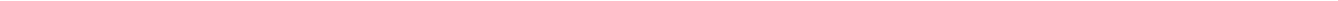
Figure 3 | Knockout of VCAM1 in oligodendrocytes decreases myelin marker protein expression in mice. ( a , b ) MBP-Cre-driven VCAM1 conditional knockout ( VCAM1 fl/fl ; Mbp-Cre ) and control mouse spinal cord cross sections at postnatal day 7 were stained with an antibody against GFAP (green) or NeuN (red). Data are representative. Scale bar, 200 m m ( a ); 100 m m ( b ). ( c ) The intensity of GFAP staining per one square millimetre was semi-quantified at postnatal days 7, 14 and 21. Data were evaluated using Student’s t -test (non-significance; n ¼ 6 slices of two independent experiments). ( d ) The number of NeuN þ cells per field was counted. Data were evaluated using Student’s t -test (non-significance; n ¼ 5 slices of two independent experiments). ( e ) Spinal cord cross sections of VCAM1 fl/fl ; Mbp-Cre and control mice at postnatal day 7 were co-stained with an antibody against CC1 (red) and DAPI (blue). Data are representative. Scale bar, 100 m m. ( f , g ) Antibodies against CC1 (red) and Olig2 (green) were used for co-staining in spinal cord cross sections at postnatal days 7, 14, 21 and 28. Data are representative. Scale bar, 100 m m. The percentage of CC1 þ cells among the Olig2 þ cells is shown. Data were evaluated using Student’s t -test (** P ¼ 0.00638 (P7), 0.000961 (P14), 0.00111 (P21) or 2.11E-09 (P28); n ¼ 6–10 slices of two independent experiments). ( h , i ) Corpus callosum sections of VCAM1 fl/fl ; Mbp-Cre and control mouse ( h ) or VCAM1 fl/fl ; Ng2-Cre and control mouse ( i ) at postnatal day 11 were co-stained with an anti-MBP antibody (red) and DAPI (blue). Data are representative of six slices of two independent experiments. Scale bar, 200 m